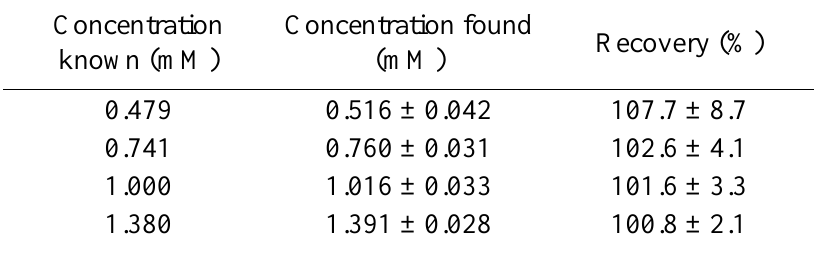
Table 2 . Recovery test of benzoic acid added to the artificial juice matrix (n =